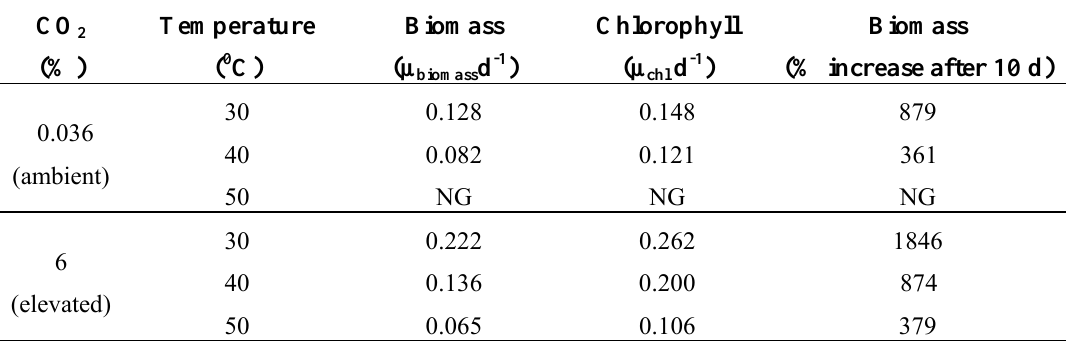
Table 1. Specific growth rate (based on biomass and chlorophyll content) and biomass productivity of C. vulgaris